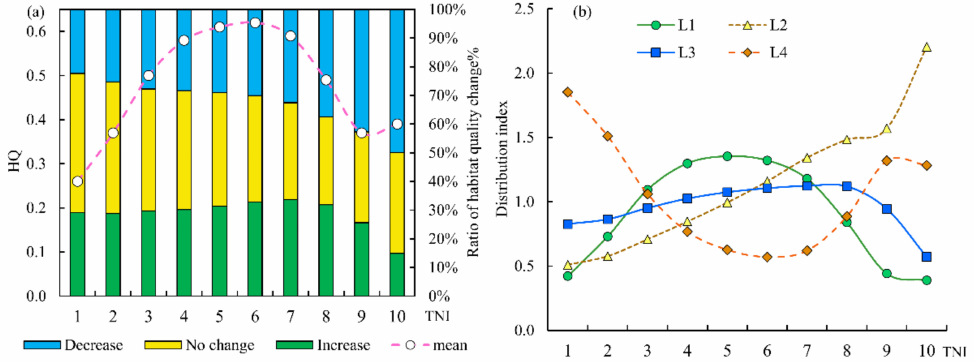
Figure 8. The habitat quality change from 1995 to 2015 ( a ), and the distribution index of habitat quality level at different terrain niches ( b